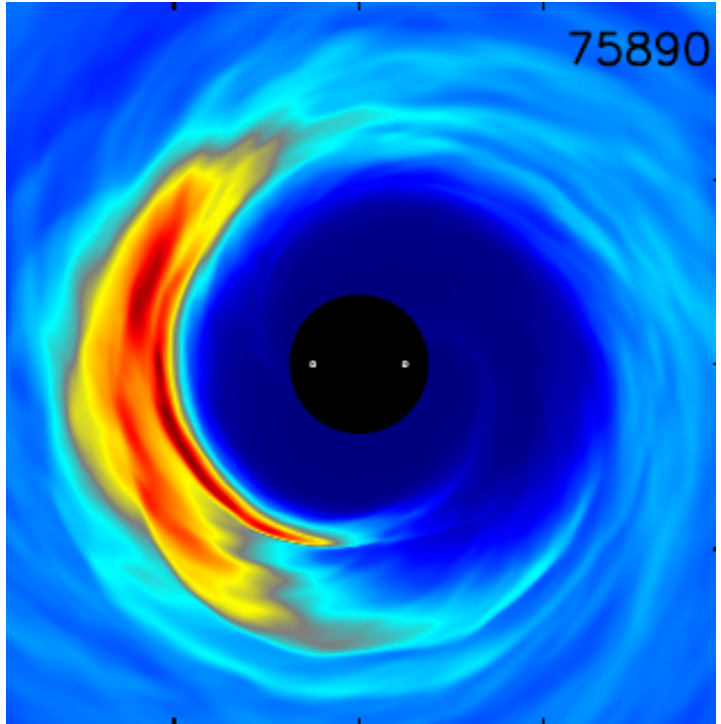
Figure 1. Rest-mass density (linear color scale) from [55] a GRMHD simulation in a spacetime framework similar to [72]. A persistent non-axisymmetric overdensity termed a “lump” develops in the bulk of the